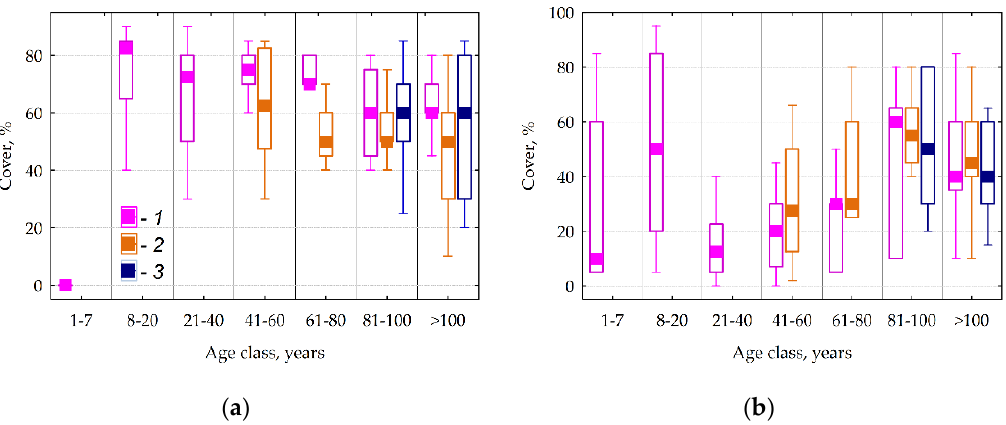
Figure 3. ( a ) Box plot of cover of tree layer in plantations; ( b ) box plot of cover of undergrowth layer for various ages; 1 —spruce plantations; 2 —pine plantations; and 3 —native spruce communities. Box-whisker type: median / 25 and 75 percentiles / nonoutlier range.